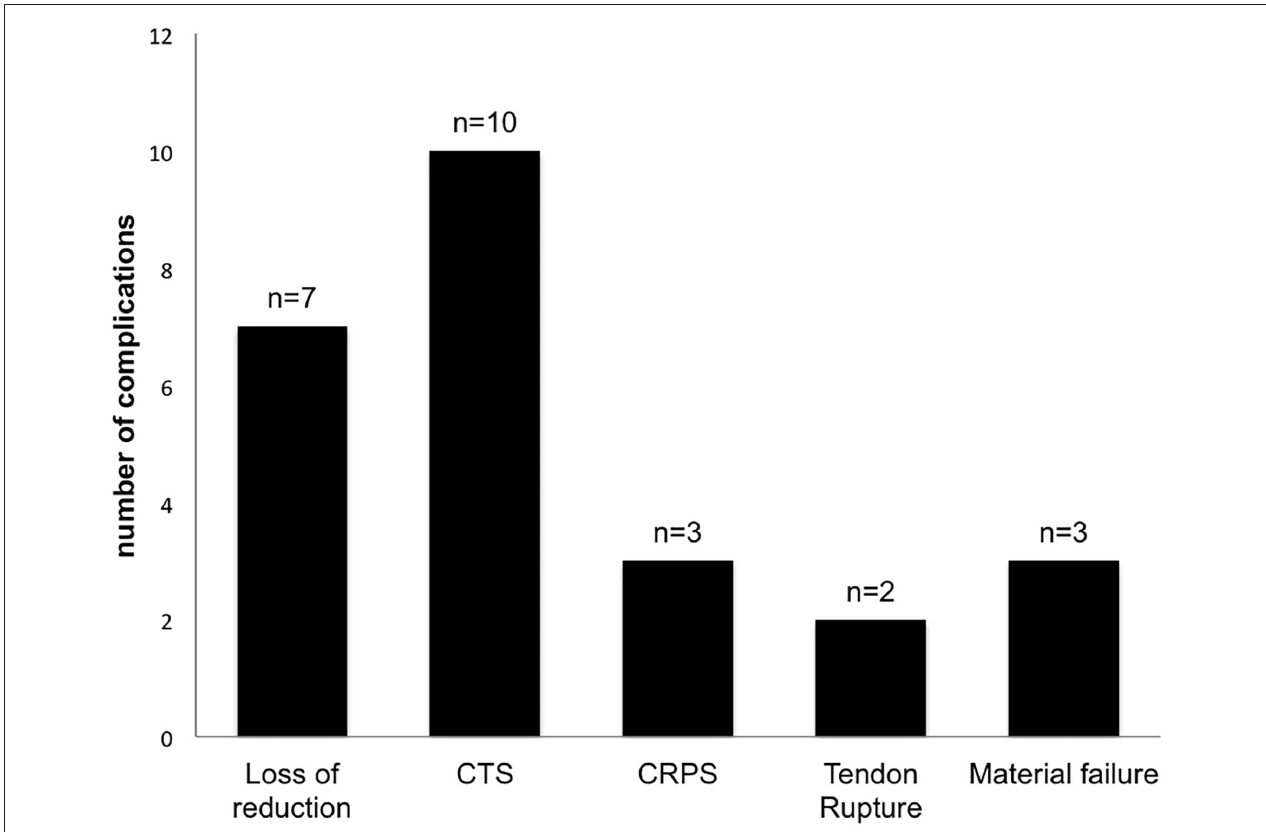
FIGURE 5 | Complications. Complications were documented in 25 cases (7%), containing loss of reduction ( n = 7), carpal tunnel syndrome ( n = 10), complex regional pain syndrome (CRPS) ( n = 3), material failure ( n = 3), and tendon rupture ( n = 2).